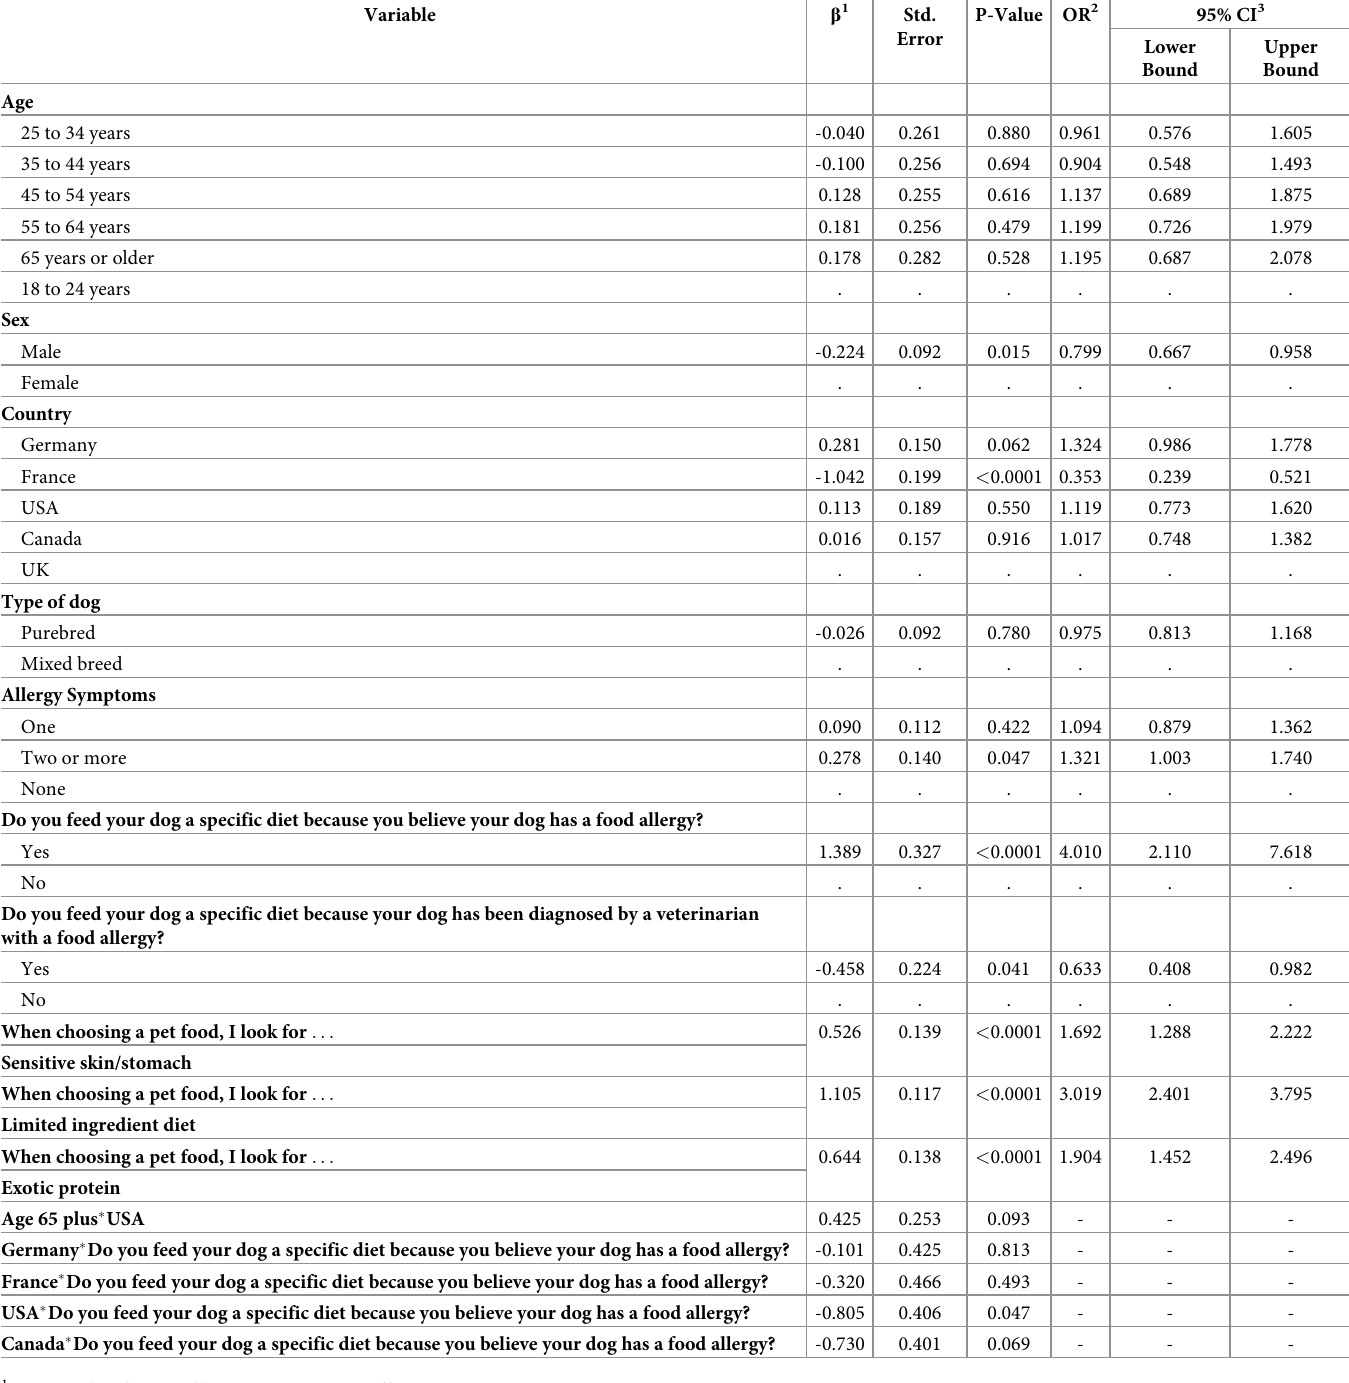
1 Estimated multinomial logistic regression coefficient 2 Odds Ratio or exponentiation of the coefficient ( β ) 3 95% Confidence Interval of the Odds Ratio McFadden Pseudo R-Square =